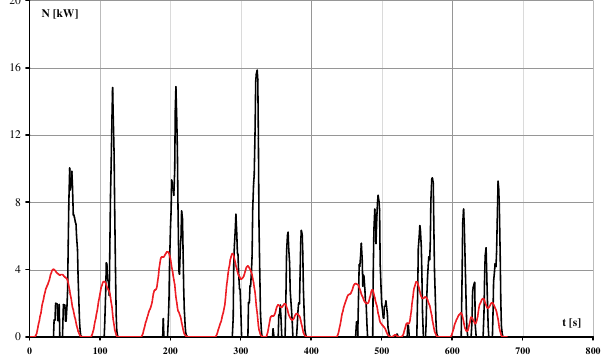
Fig. 5. The kinetic power (black color) and resistance power (red color) of the movement at the average traffic intensity